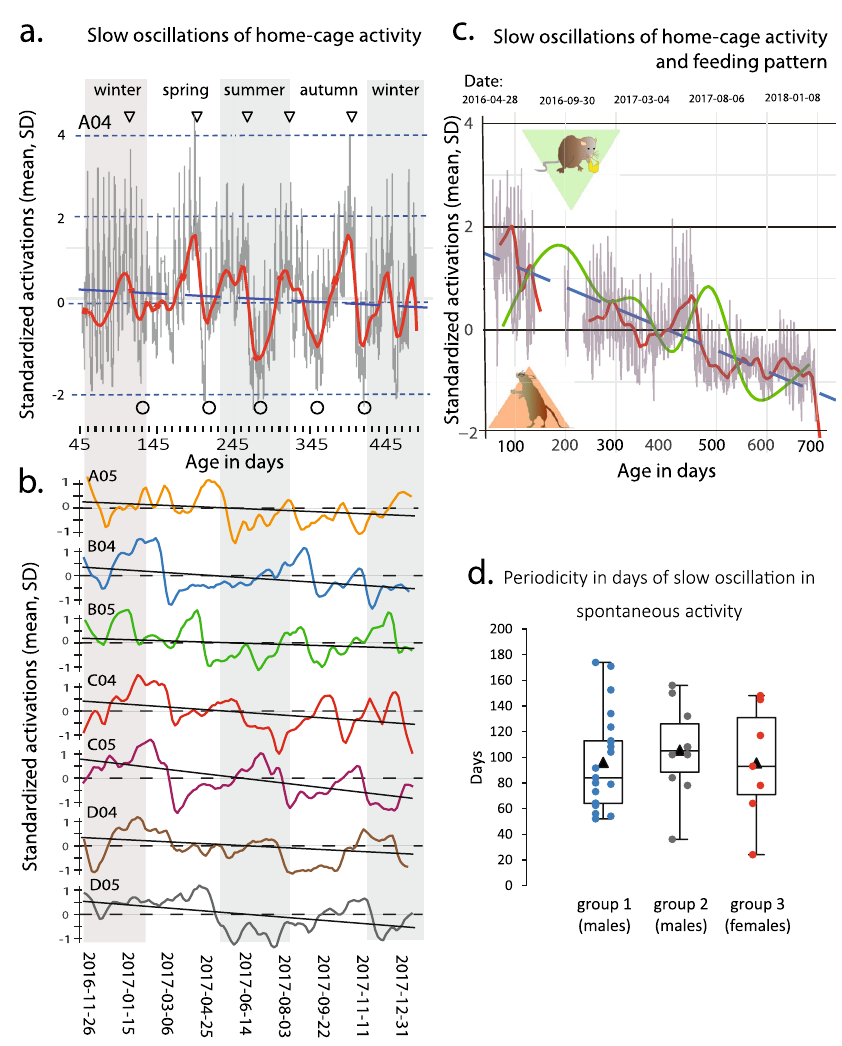
Figure 4. ( a ) Upper panel shows plot of normalized (see Methods) activations (ordinate is mean and standard deviations of the mean) for cage A04 also shown in Figs. 1c and 2, with highs indicated by inverted triangles (same as in Fig. 1c) and lows by open green circles at the bottom. On top of the slow rhythm and having a similar amplitude is the recurring response to the cage-change which occurs with the period of 1 week (for further details of the plot see Supportive information Fig. S3). The slow rhythmicity is indicated by the red curve and the interrupted blue line is the linear regression showing the over-all decrease in activations with advancing age. The data has been plotted against dates (abscissa bottom), age in days (abscissa middle) and with the seasons of the year as background (abscissa at the top, intervened grey-and-white vertical stripes). ( b ) Lower panel is the slow rhythmicity (continuous line with different color for each cage) of the complementary 7 cages in Group 1 along with the linear regression of the each cumulative record showing the decrease with advancing age (black line). The abscissa ordinates are the same as in a. ( c ) shows normalized activations (as in a) up to an age of 699 days in one cage belonging to group 2 (Cage E; activations data available in Supportive information Fig. S2I) where food consumptions (average across one week; see Methods) was measured (green line). The red curve indicates the slow oscillation in activations while the interrupted blue line is the regression of overall change in activity with advancing age. The slow oscillations in food consumption (green) and activations (red) are highly correlated r 2 = 0.72. ( d) Boxplots visualizing the period of slow oscillations in the three groups of cages. The observation from each cage in each of the groups have been indicated by separate color-filled circles. The average period in group 1–3 is 96, 106 and 96 days,